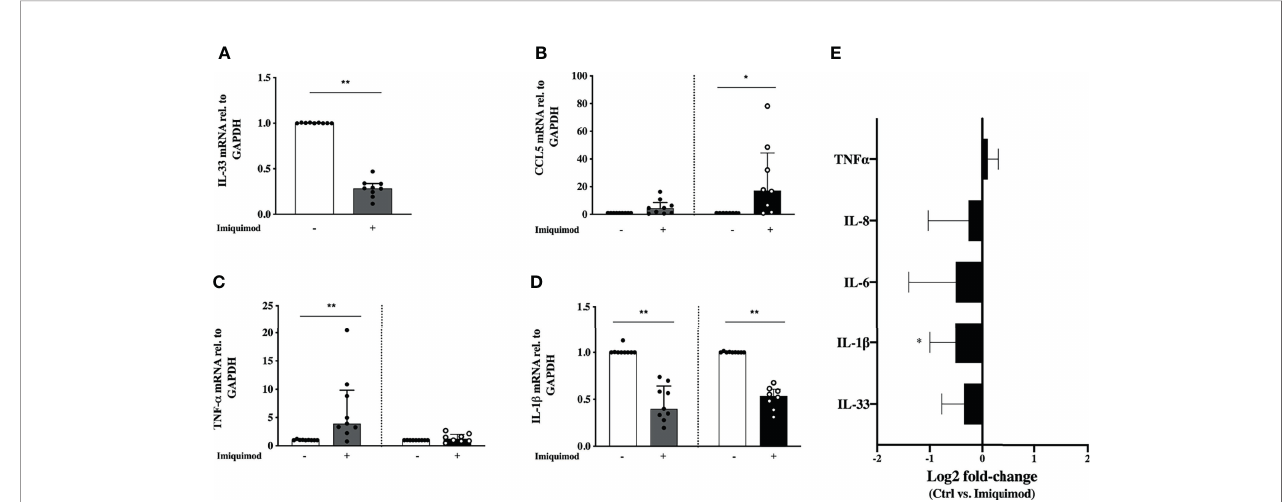
FIGURE 2 | Effects of imiquimod treatment on pro-in fl ammatory response of human bronchial epithelial cells (HBECs) from steroid-free asthmatic patients. Imiquimod effect on the mRNA expression of the pro-in fl ammatory mediators IL-33 (A) , CCL-5 (B) , TNF- a (C) and IL-1 b (D) is depicted. (E) Log2 fold-change expression of TNF- a , IL-8, IL-6, IL-1 b , and IL-33 in cell culture supernatants from HBECs after 24 hours of imiquimod treatment measured by multiplex ELISA (Luminex). *p < 0.05; **p < 0.01, Wilcoxon Signed Rank Test. HBECs from study population 1 were used, N = 7-9.